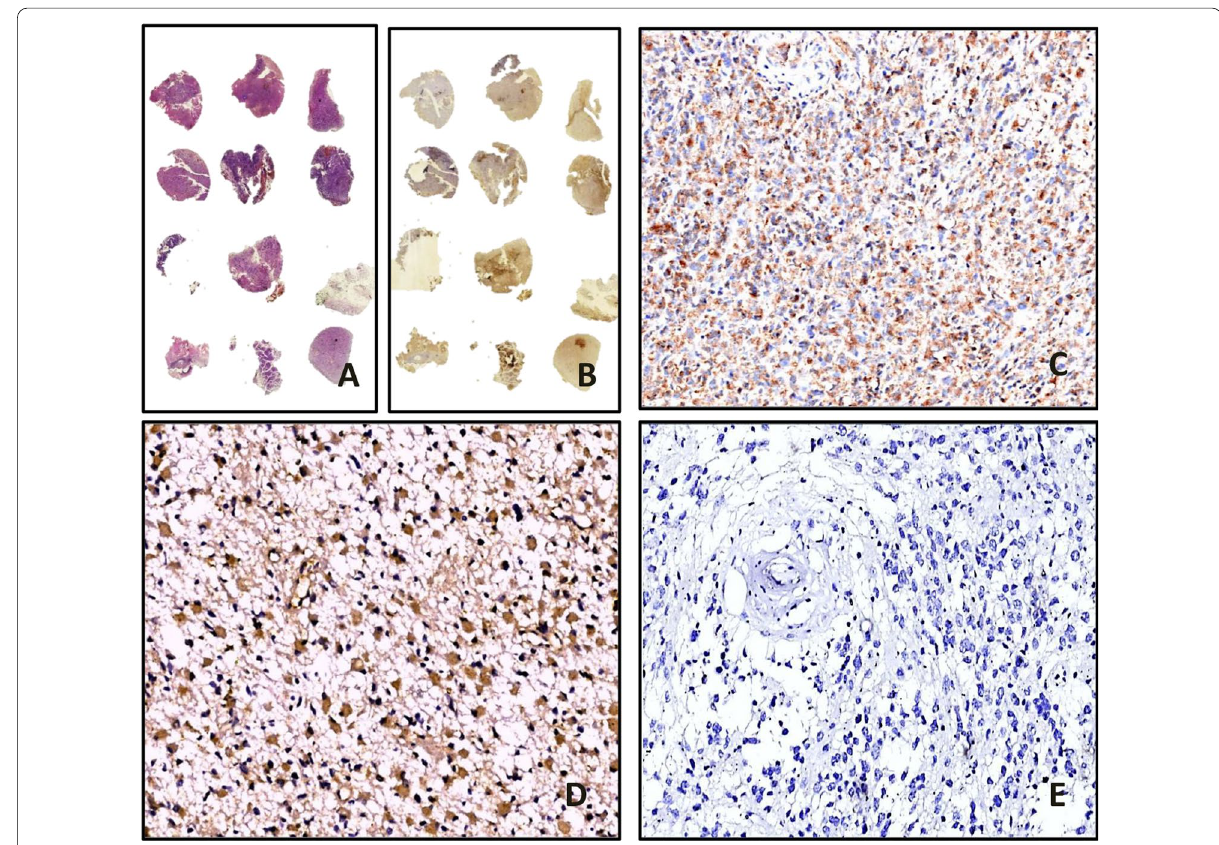
Fig. 1 Overall image of sections from a TMA block. H&E stained section ( A ) and IDH1-R132H immunohistochemically stained section ( B ). Oligodendroglioma grade 2, IDH1-mutant showing positive cytoplasmic staining by IDH1-R132H (positive control), original magnification ( C ). Astrocytoma WHO grade 2, IDH1-mutant with gemistocytic differentiation, showing positive cytoplasmic staining by IDH1-R132H, original magnification 200 ( D ). Glioblastoma NOS, WHO grade 4, showing negative staining by IDH1-R132H, with endothelial proliferation, original × magnification 200 ( E ×